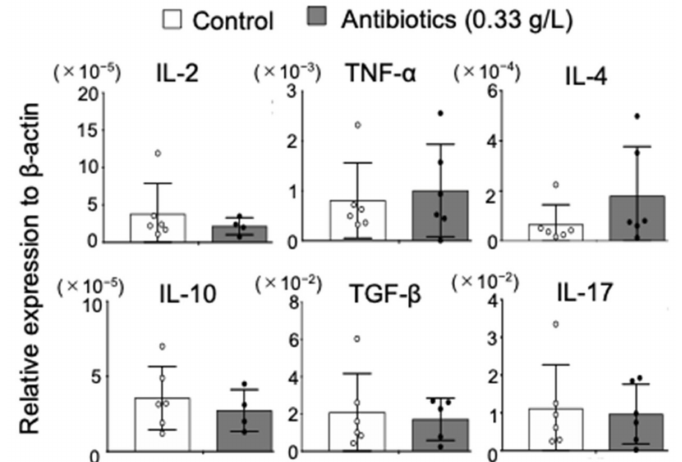
Figure 3. Effect of antibiotic administration on cytokine mRNA expression. Th1 (IL-2 and TNF- α )-, Th2 (IL-4, IL-10, and TGF- β )-, and Th17 (IL-17)-type cytokines in the spleen of control and antibiotic (0.33 g/L)-administered NOD mice were evaluated by quantitative Reverse Transcription-PCR (RT-PCR). Data are presented as mean ± SD of four to six mice in each group.